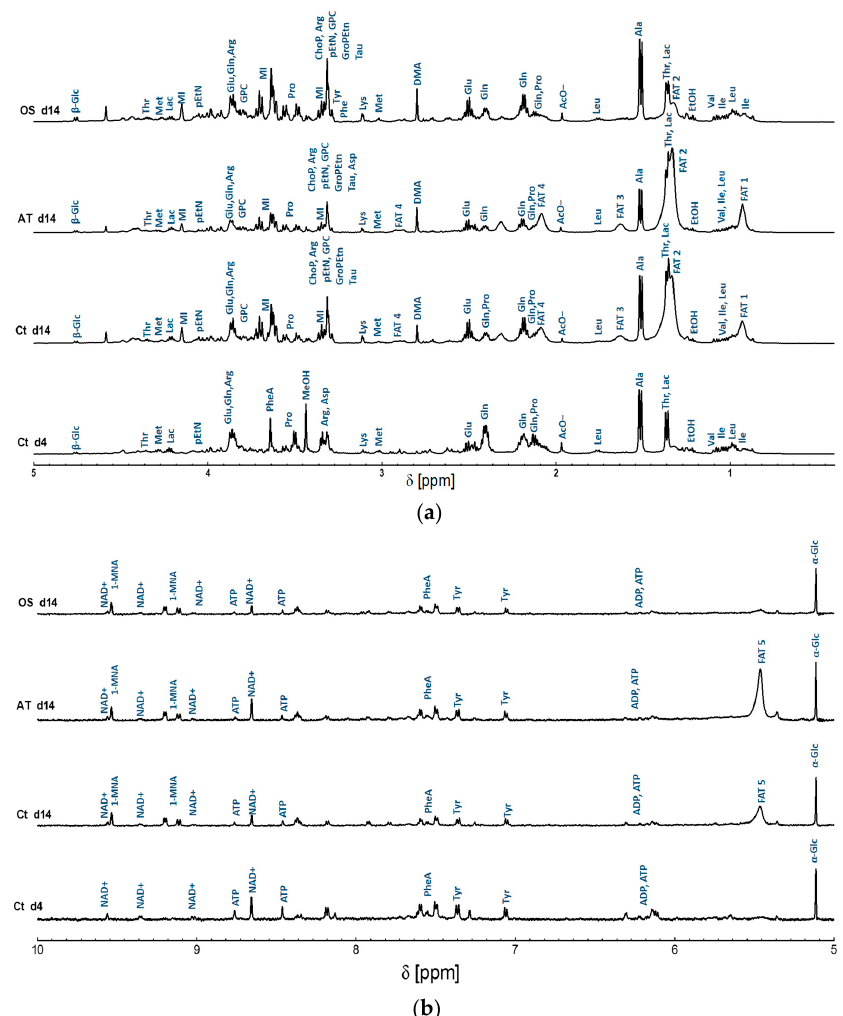
Figure 2. Representative high resolution 1 H NMR spectra of intracellular metabolite extracts obtained from AT-derived hMSC samples collected at day 14 of differentiation into adipocytes and osteocytes, and their control samples represented in AT-derived hMSC collected at day 4 and 14 of cultivation in BCM. ( a ) 0.4–5 ppm region; ( b ) 5–10 ppm region. Peak assignment: Ile: Isoleucine; Leu: Leucine; Val: Valine; Thr: Threonine; Lac: Lactate; Ala: Alanine; Glu: Glutamine; Gln: Glutamate; Pro: Proline; Met: Methionine; Lys: Lysine; Arg: Arginine; GPC: Glycerophosphorylcholine; α -Glc: Alfa-Glucose; β -Glc: Beta-Glucose; MI: myo-inositol; ChoP: O-Phosphocholine; pEtN: Phosphorylethanolamine; GroPEtn: Glycerophosphorylethanolamine; ATP: Adenosine triphosphate; ADP: Adenosine diphosphate; Tyr: Tyrosine; Phe: Phenylalanine; NAD+: Nicotinamide adenine dinucleotide; Tau: Taurine; Asp: Asparagine; 1-MNA: 1-methylnicotinamide; AcO-: Acetate; DMA; Dimethylamine. In addition to the fatty acids signals; namely FAT 1, FAT 2, FAT 3, FAT 4, and FAT 5, representing methyl group -CH 3 , Acyl chains-(CH 2 )n-, methylene group -CH 2 -CH=CH, vinyl hydrogen -CH=CH, and diallyl methylene group =CH-CH 2 -CH=, respectively. The presence of ETOH (ethanol) and MeOH (methanol) was observed to represent residues from the cleaning and extraction